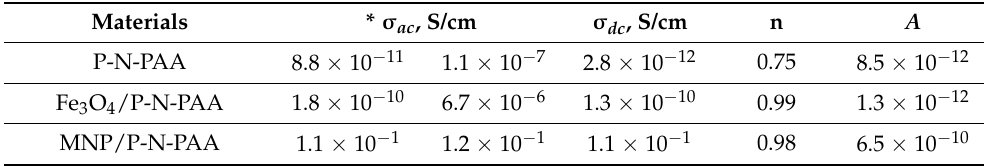
Table 5. The conductivity values of materials.